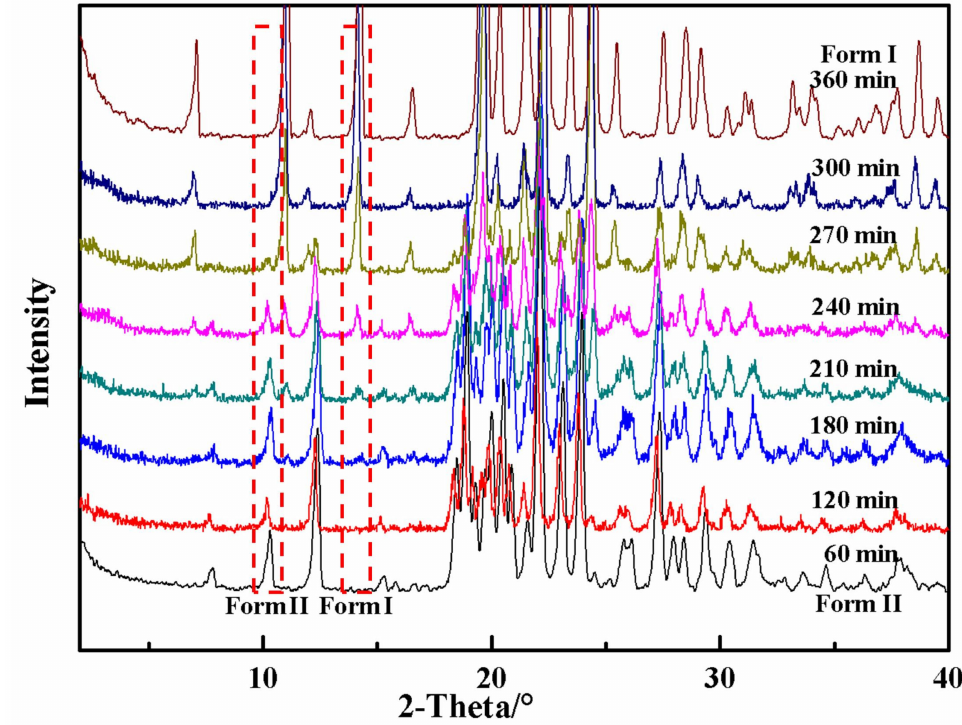
Figure 9. Powder X-ray diffraction patterns at different times during the solution-mediated polymor- phic transformation of L-carnosine in a water + ethanol binary solvent